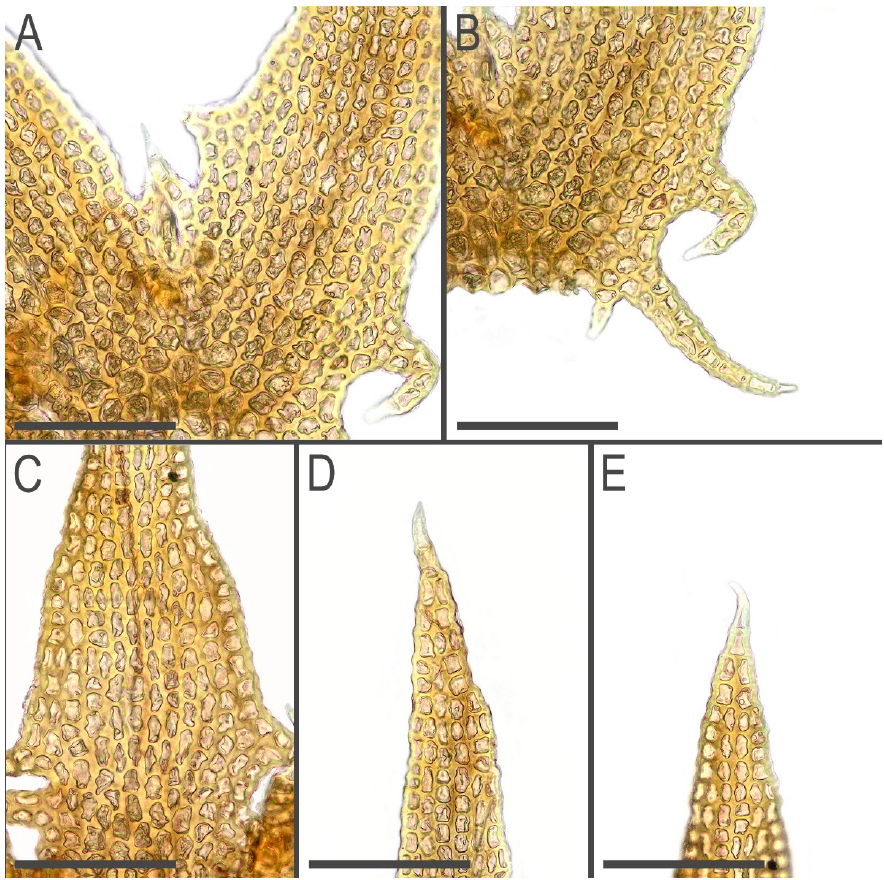
Figure 12. Tetralophozia pusilla (Steph.) Bakalin et Vilnet: A – C —leaf lobe bases; D , E —leaf lobe apex. Scales: A – E —100 µ m. All from J-88-40-15 (VBGI).